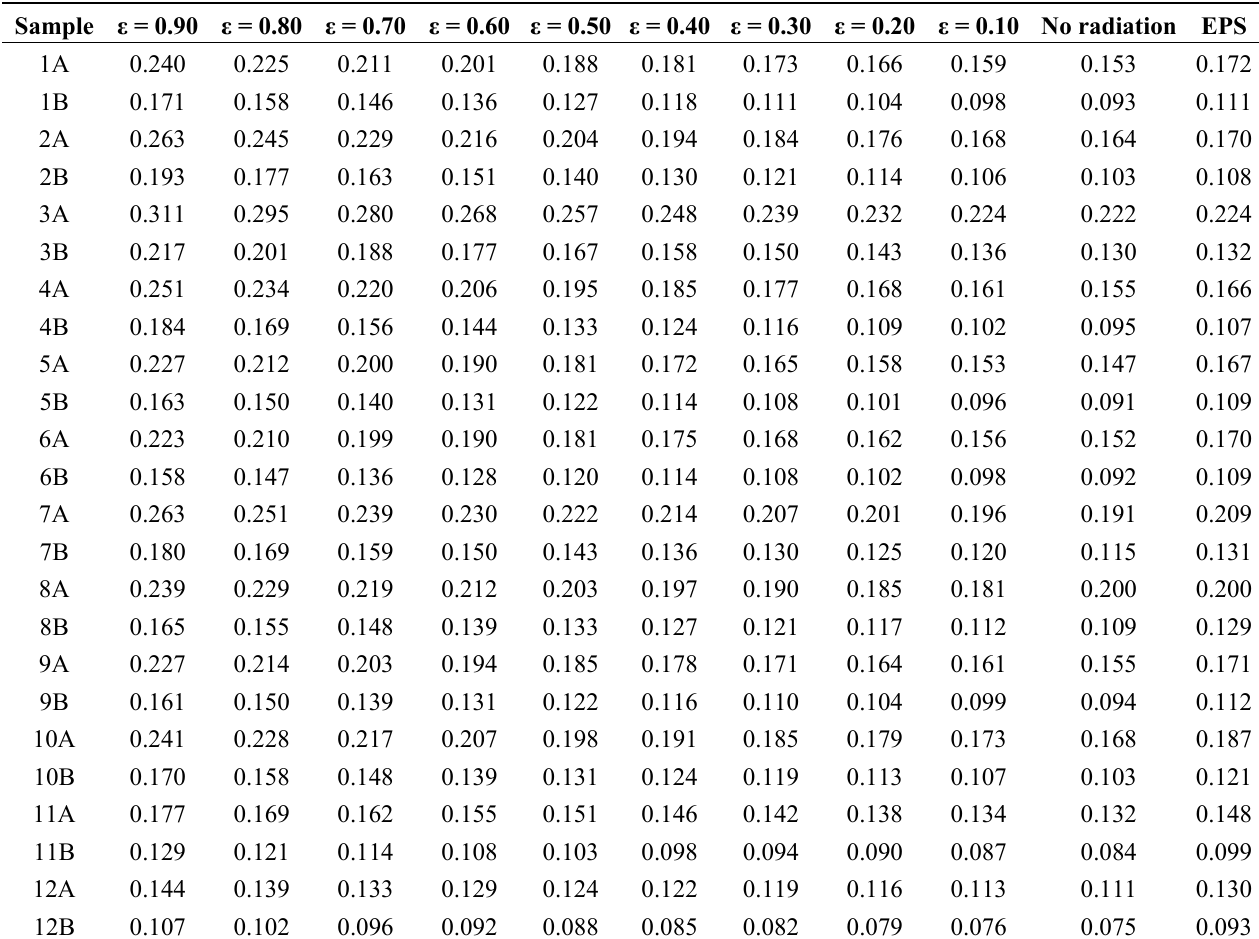
Table 6. Equivalent thermal conductivity of the evaluated block